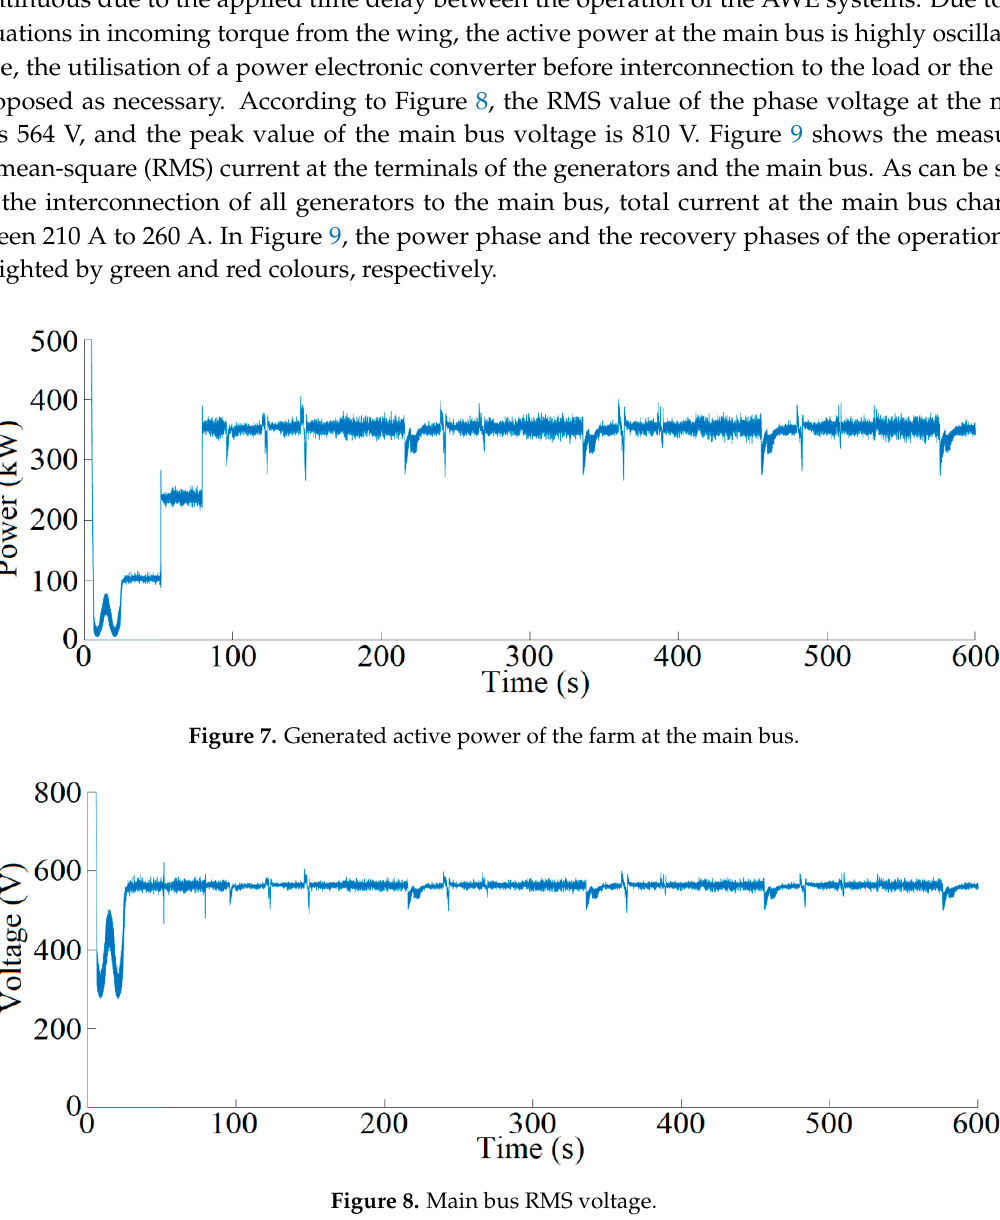
Figure 8. Main bus RMS voltage.